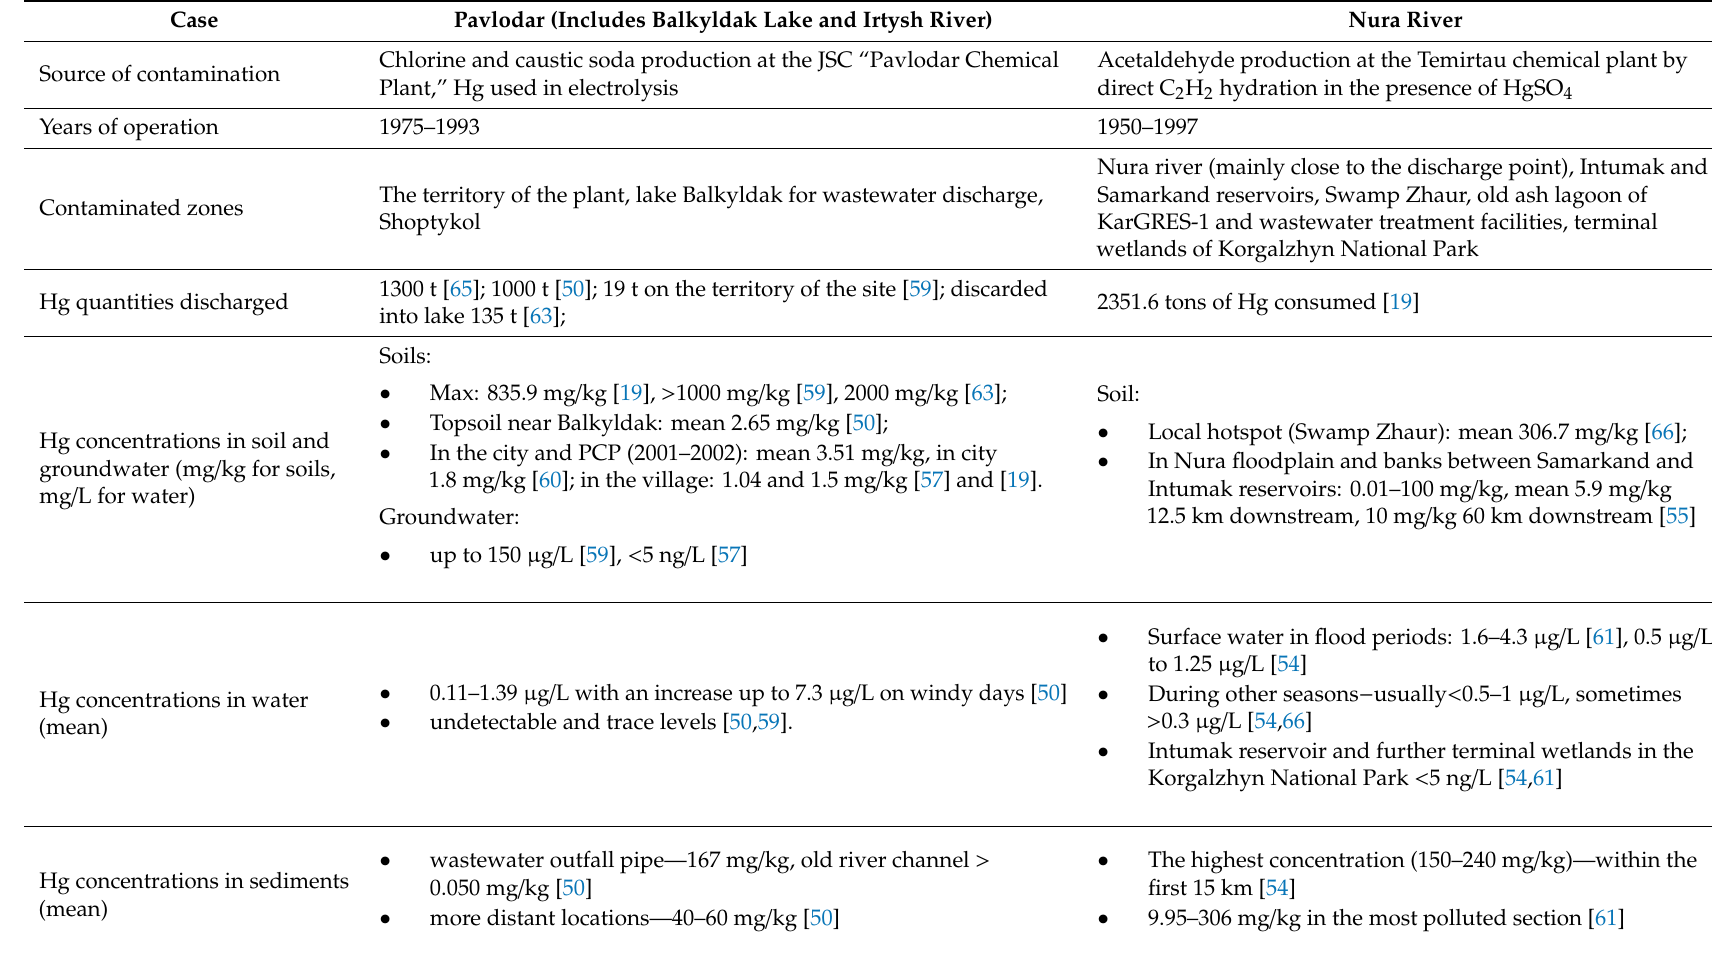
Table 3. Comparison of two cases of Hg contamination in